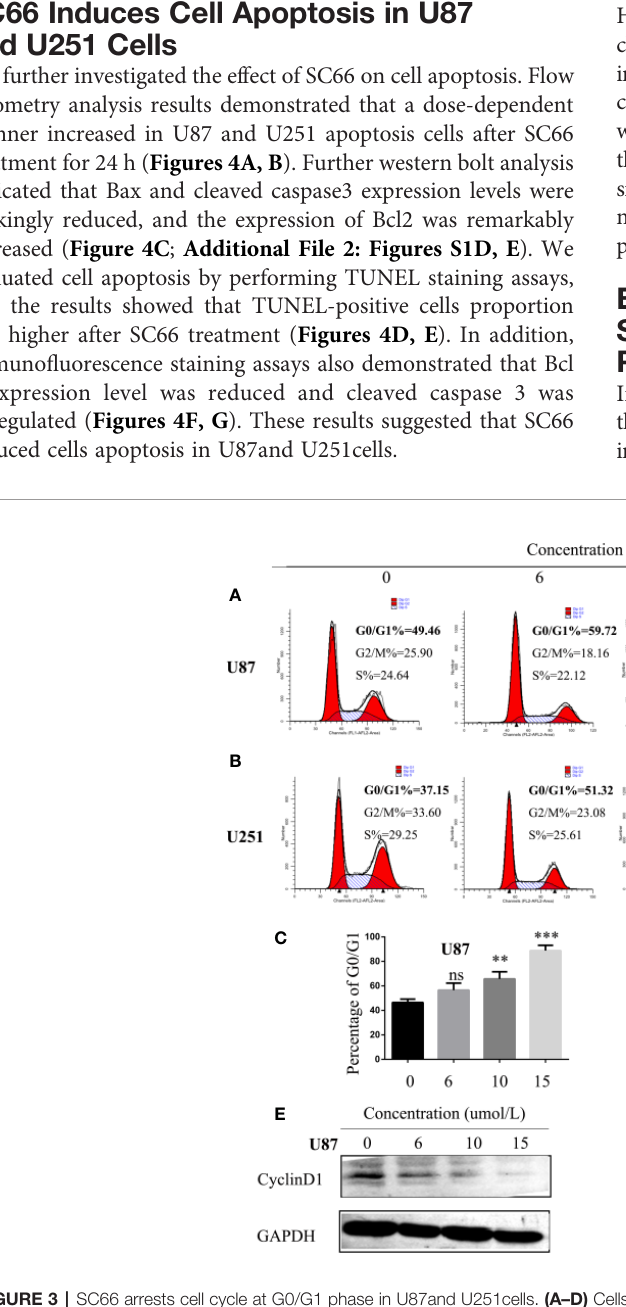
FIGURE 3 | SC66 arrests cell cycle at G0/G1 phase in U87and U251cells. (A – D) Cells accumulated at the G0/G1 phase after SC66 treatment for 24 h measured by fl ow cytometry and results were statistically analyzed. (E, F) Cell cycle protein expression quanti fi ed with western blot. For at least three independent experiments. n.s., no signi fi cance; **P < 0.01, ***P <